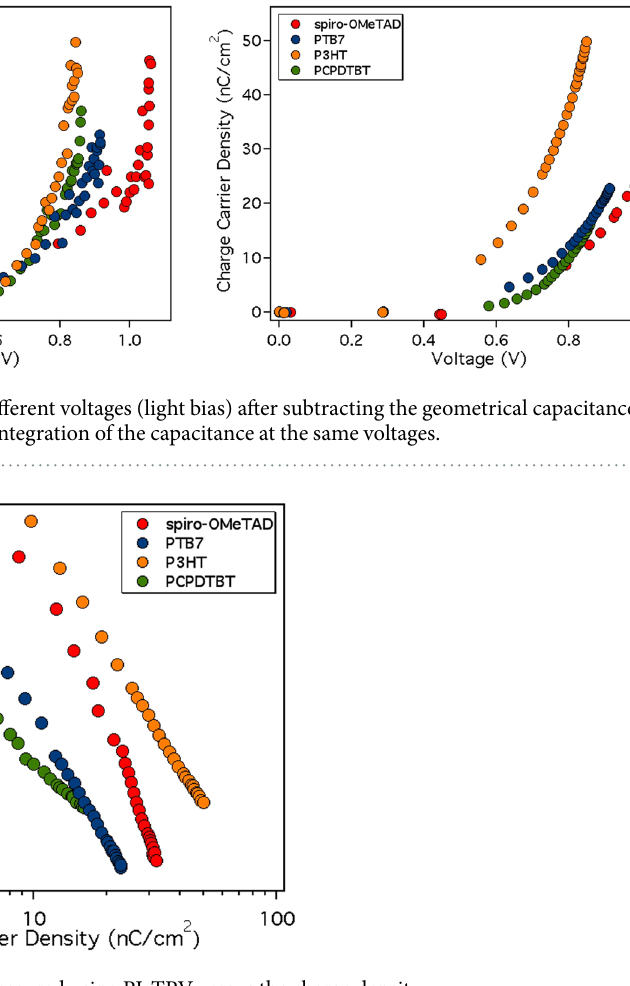
Figure 9. The carriers’ lifetime measured using PI-TPV versus the charge